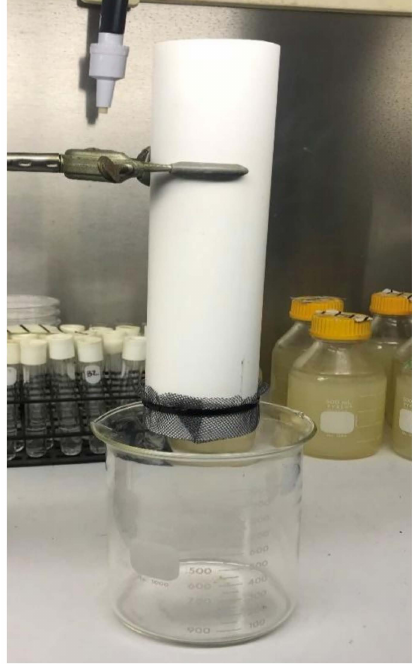
Figure 3. Column set-up is held vertically with a ring clamp and a graduated beaker is placed underneath for collection of flow through. Column contains washed decomposed granite, 0%, 2%, or 5% biochar and 1 L storm water sample collected from Malakoff Diggins. Samples were passed through gravimetrically, and collected in 1 L graduated